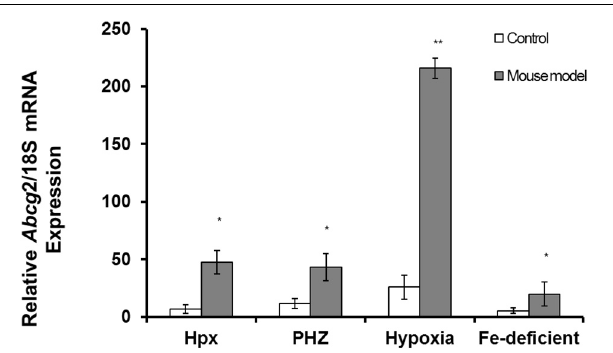
FIGURE 2 | Quantitative Real-Time PCR of Abcg2 mRNA levels in spleen of mouse models with enhanced erythropoiesis. Abcg2 mRNA levels in the spleen of Hpx, PHZ-treated, hypoxic, and iron-deficient mice. Data are mean ± s.e.m. of four observations in each group and are expressed as a ratio of 18S mRNA in arbitrary units. Analysis by Students’ T -test showed significant effects of abcg2 mRNA in Hpx ( P < 0 . 01), PHZ ( P < 0 . 01), hypoxia ( P < 0 . 05), and iron-deficient spleen tissues, ( P < 0 . 05) over the control samples.